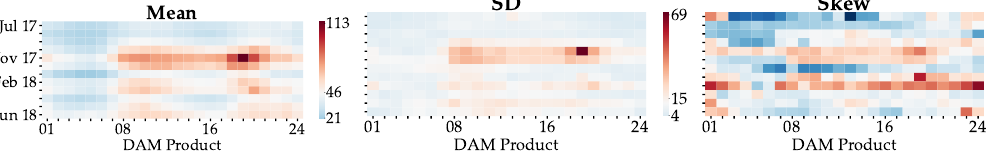
Figure 4. Heatmaps showing monthly means ( left ), standard deviations ( centre ), and skewness ( right ) of the test set prices ( € /MWh). These metrics are calculated for each hour denominated DAM contract, to highlight both the periods and products exhibiting higher than average price, volatility, and skewness. Note that the colour bars are centred at each metrics mean value to facilitate our analysis.